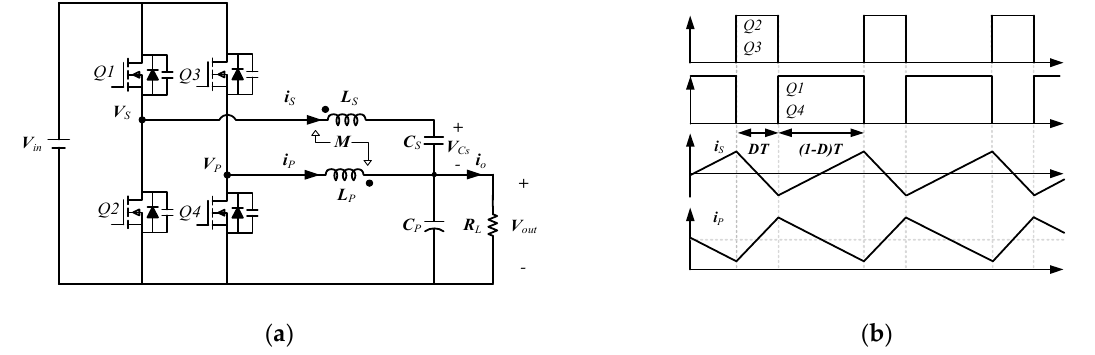
Figure 7. Stacked buck converter: ( a ) Circuit architecture diagram; ( b ) Operation sequence diagram.